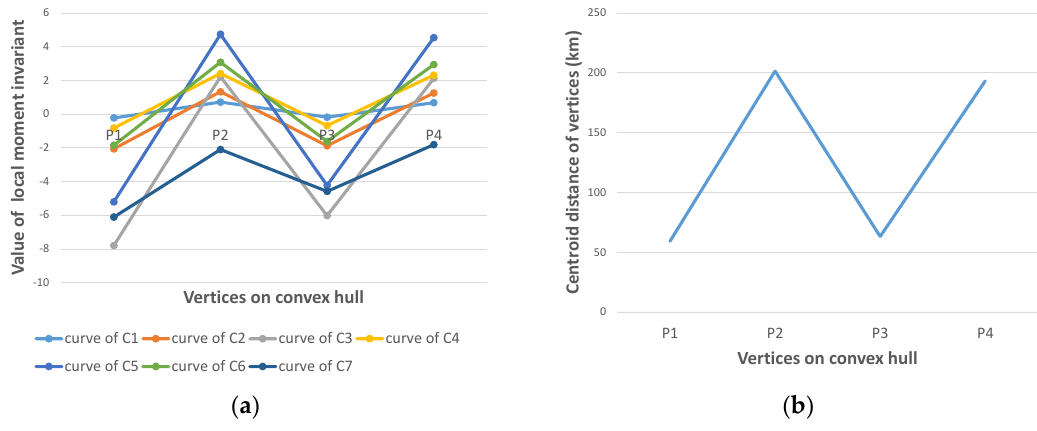
Figure 5. Convex hull moment invariant curves of the polygon in Figure 4: ( a ) Convex hull moment invariant curves and ( b ) centroid distance of convex hull vertices.